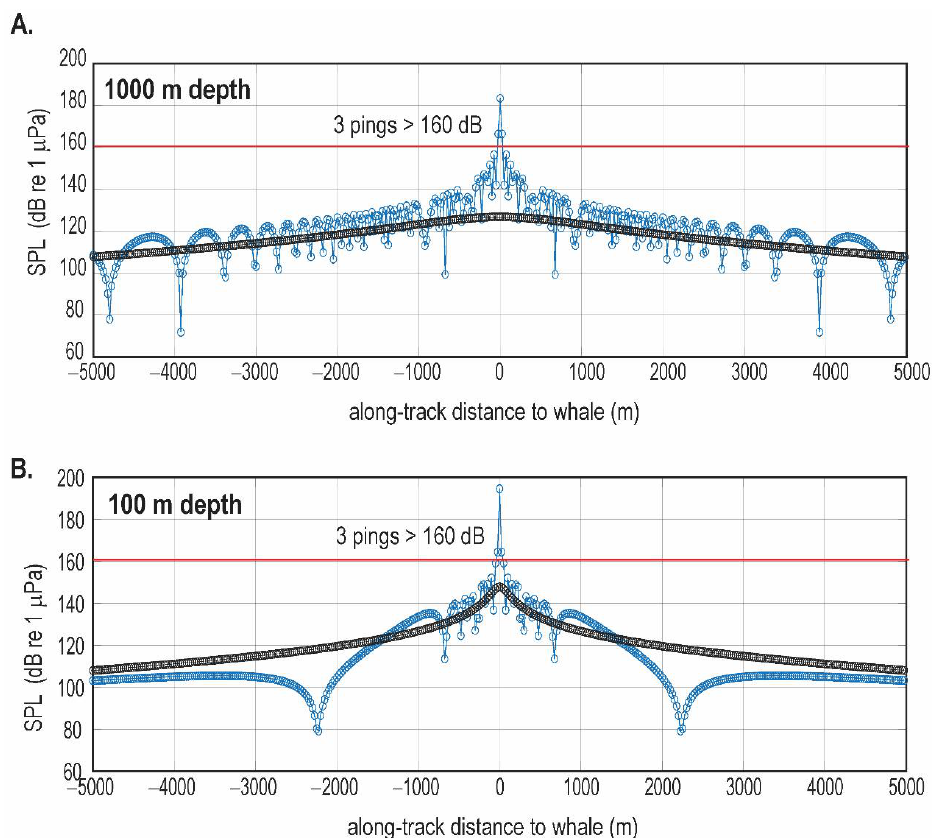
Figure 11. Blue circles show SPL received by a stationary animal at ( A ) 1000 m and ( B ) 100 m water depth as an EM122 (12 kHz) mounted on a ship’s hull with the geometry as shown schematically in the inset to Figure 9A. For this model, the EM122 is operating in single swath mode, the beamwidth is 0.5°, and the MBES transmits a CW signal with 15 ms pulse length as the ship travels at 5 m/s (9.7 knots). For comparison, the black circles show SPL calculated for an omnidirectional de minimis source (160 dB at 25 m; SL of 188 dB), and the red line is a reference level of 160 dB re 1 μPa. In Figure 11, three pings (pulse exposure) exceed the SPL threshold of 160 dB re 1 μPa (e.g., Figure 10B) for EM122 15 ms (CW) pulses repeated every 5 s, and the highest received SPLs are 195 dB and 183 dB re 1 μPa for the animals at 100 and 1000 m depth, respectively. For the sake of comparison, we also plot the DMODS for which SPL reaches 160 dB re 1 μPa within 25 m of the source (related to Factor 2, with R it = 25 m). The EM122 calculation is for single swath mode. In normal operations, a 0.5° EM122 would be oper- ated in dual swath mode, transmitting two 15 ms pings (one each pitched slightly forward and backward) separated by a few hundred milliseconds. This effectively doubles the number of pings (from 3 to 6) that could exceed 160 dB re 1 μPa, although a stationary animal could receive the highest SPL for only a single of any two-ping pair. Changes in along-track beamwidth, which was taken as 0.5° in Figure 11, do affect the SPLs. Larger beamwidth widens the along-track zone where the SPL is near the high- est values, but also lowers the system’s SL and thus received SPL values, by as much as 9 dB [58]. Thus, a few additional pings may exceed the 160 dB re 1 μPa threshold for larger beamwidth, but most pings will be at a lower SPL. Repeating the calculation for a 2° EM122 with an SL of 236 dB re 1 μPa @ 1m (with other parameters the same) yields SPL for the five highest pings of 196 dB (1 ping), 160 dB (2), and 159 dB (2) re 1 μPa at 100 m depth and 175 dB (1), 168 dB (2), and 160 (2) re 1 μPa at 1000 m depth.